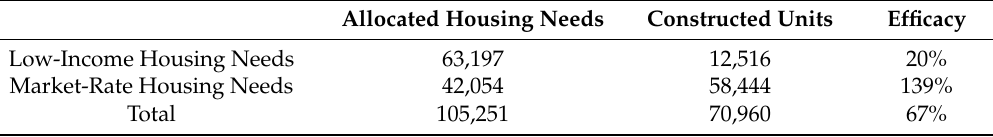
Table 7. The sample’s efficacy of allocated housing needs to constructed units. The sample’s housing allocation achieved an overall efficacy of 67%, a market-rate efficacy of 139%, and a low-income housing efficacy of 20% as indicated by the 2015–2023 housing plans and California Department of